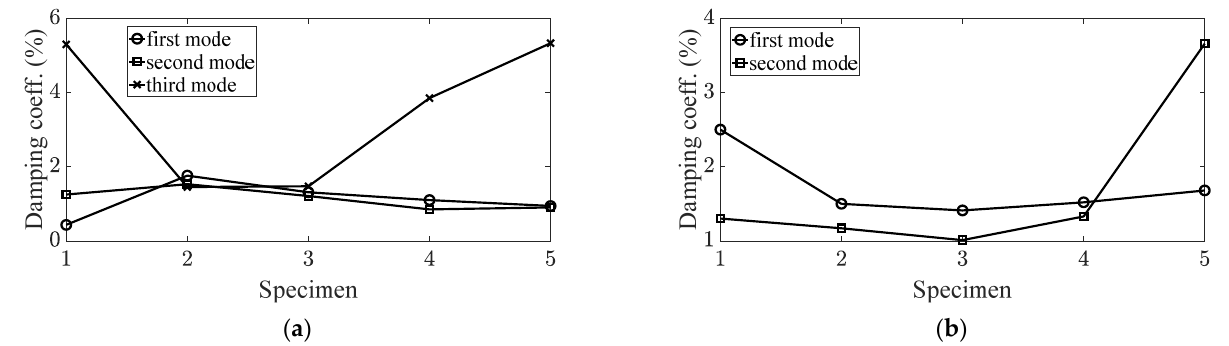
Figure 8. Variations in modal damping ratios based on carbon fiber angle: ( a ) bending modes; ( b ) torsional modes.